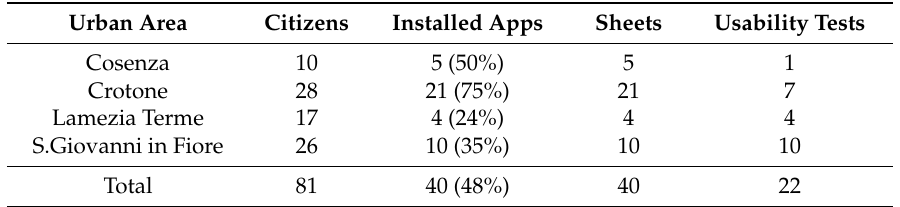
Table 3. Participant’s